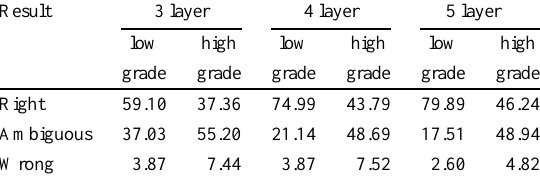
Percentages of nuclei classified by best networks, broken into